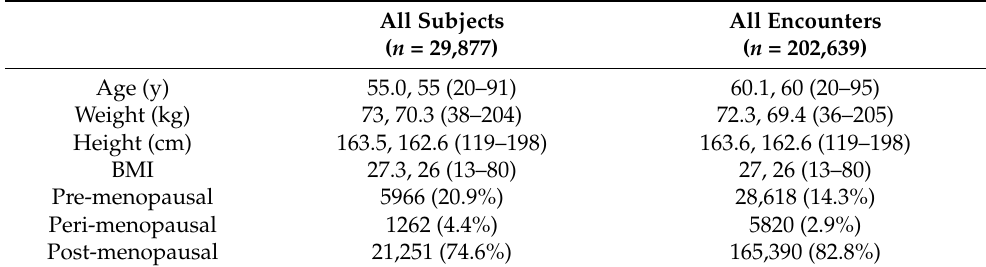
Table 1. Demographic characteristics of women undergoing TVS. Data represented as mean, median, (range). Subject data are for the first encounter, while encounter data are across all encounters. All Subjects ( n =